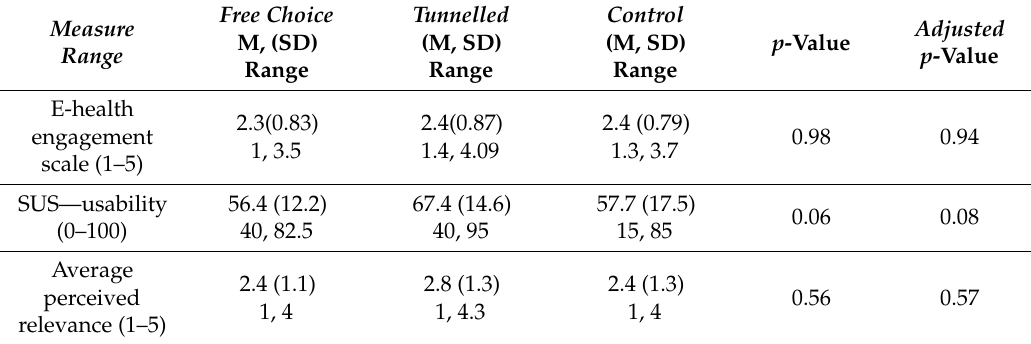
Table 3. Engagement, usability, relevance score comparison across the three study groups (N =